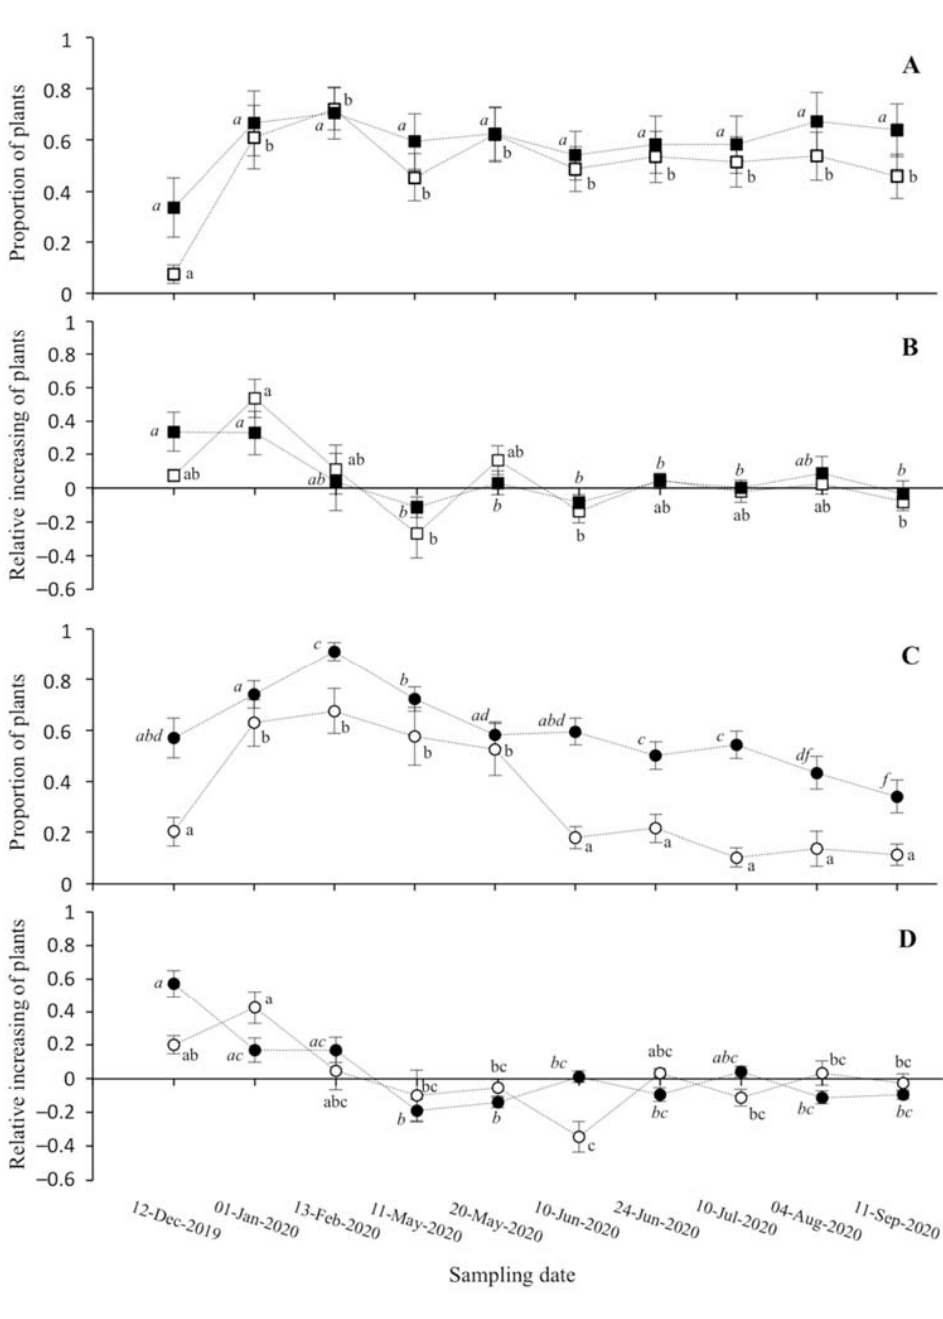
Figure 3. Density of plants ( A , C ) and increasing plant density ( B , D ) in relation to the maximum density reached for four populations of Salicornia ramosissima colonizing ( A ) elevated zones (Population 1, white squares; Population 2, black squares) and ( C ) depressed zones (Population 3, white circles; Population 4, black circles) from December 2019 to September 2020. Values are mean ± SE. The maximum density of S. ramosissima plants varied between 1715 ± 256 plants m − 2 for P2 and 18,947 ± 3683 plants m − 2 for P4, being five-times greater in depressed zones than in elevated zones (Tables 2 and 3). Thus, the maximum plant density increased together with soil-seed-bank density ( ρ = 0.760, p = 0.0041, n = 12), representing between 14 ± 3% for P1 and 31 ± 17% for P2 of the soil-seed-bank density, with no significant differences among populations (Kruskal–Wallis test: H (3,12) = 2.08, p =